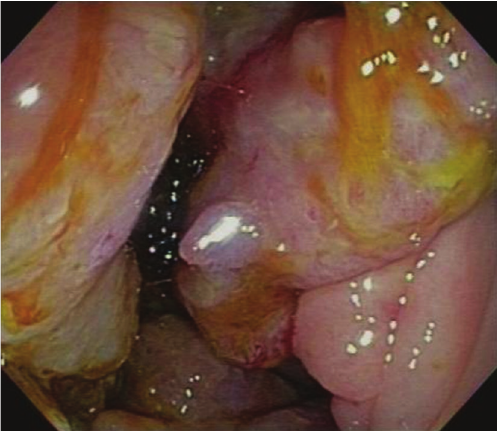
Figure 1: Large nodular hepatic flexure lesions as seen on Colonoscopy.